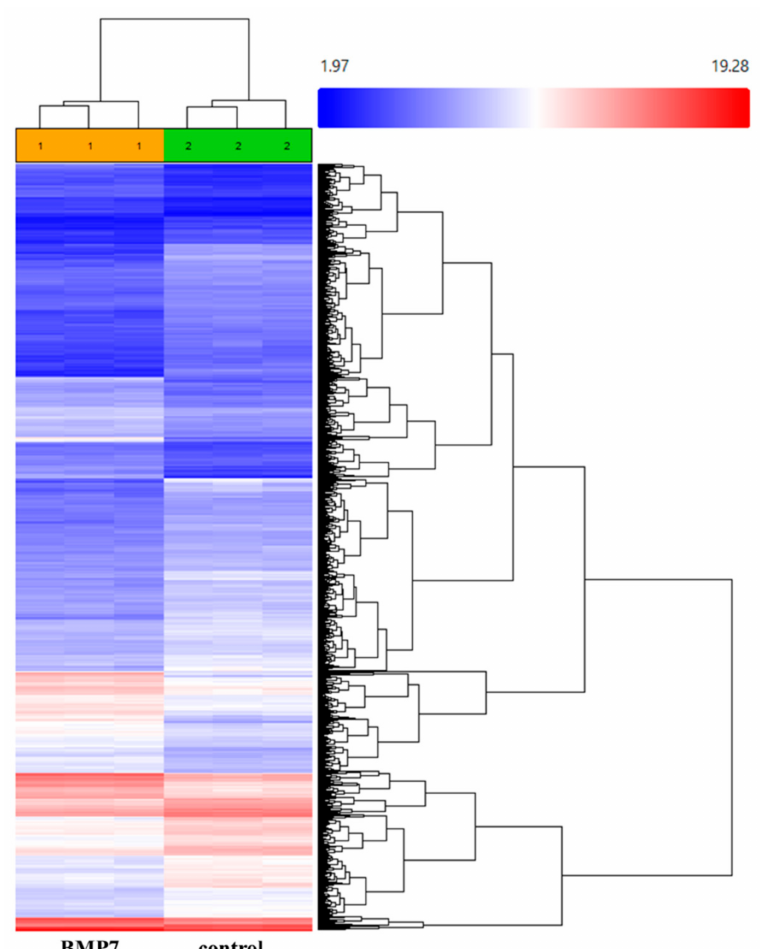
Figure 2. Hierarchal illustration of the differentially expressed genes in hTCEpi cells after treatment with BMP7 (100 ng/mL). Both twofold upregulated and downregulated genes were clustered. Untreated hTCEpi cells were served as control. After 24 h of treatment with BMP7, RNA was isolated and transcriptome-wide gene level expression profiling was performed using Clariom ™ S arrays.